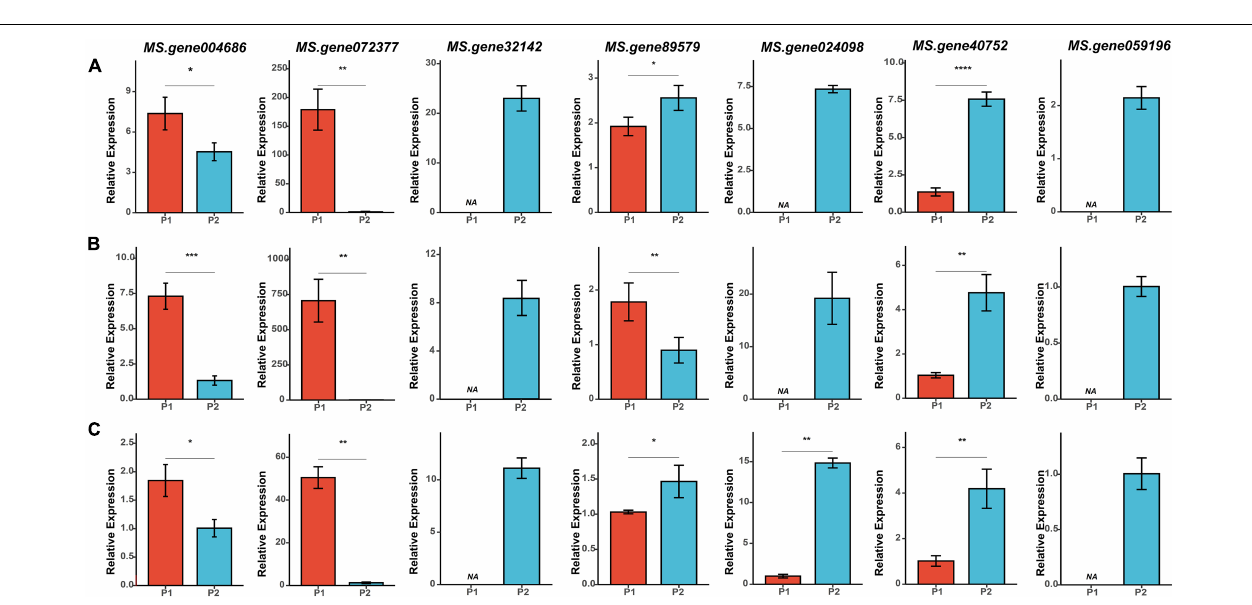
FIGURE 5 | GO enrichment of DEGs in three alfalfa flowering stages. The ordinate represents different GO terms (biological progress) and the abscissa represents enrichment Score. Circle size represents the gene number while circle color represents the value of − log10 ( P ). The P -value was corrected by Benjamini and Hochberg (BH) method.